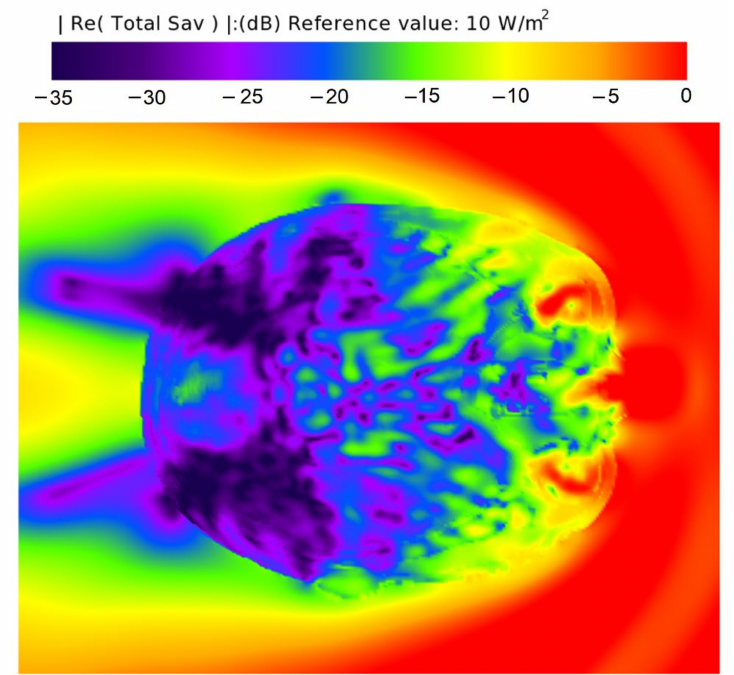
Figure 11. Power density for uncovered head, 3600 MHz (in the logarithmic scale with reference value equal to 10 W/m 2 ).